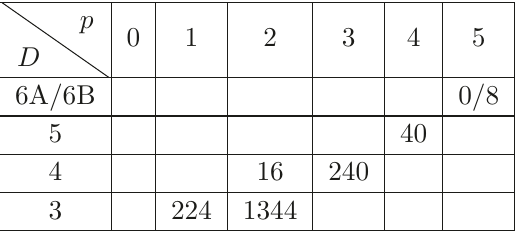
Table 14 . The α = − 5 branes in the ( T 4 / Z 2 ) × T n